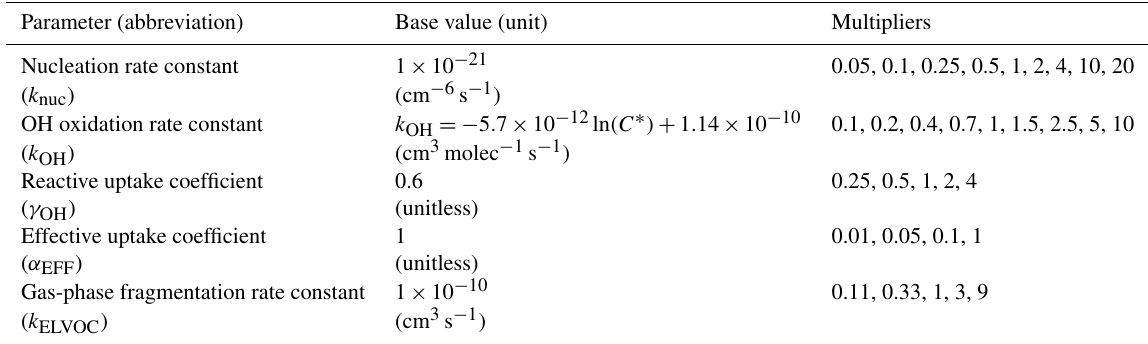
Table 3. All parameter value ranges for the suite of sensitivity simulations run in TOMAS. Parameter